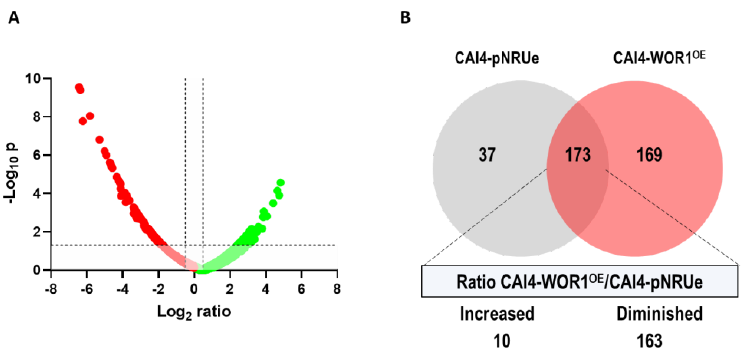
Figure 1. Proteome changes in cells overproducing Wor1. ( A ) Volcano plot of differentially abundant proteins (CAI4- WOR1 OE /CAI4-pNRUe ratio). The log 10 of the p -value is plotted against abundance (log 2 ratio) for each individual protein. Proteins that were found in lower abundance in WOR1 OE cells are shown in red whereas proteins with higher abundance are shown in green. Horizontal dotted line indicates the limit for p- values ( p = 0.05, that correspond to - log 10 p = 1.3). Vertical dotted lines indicate the log 2 ratio = ±0.5 threshold. ( B ) Venn diagram with the number of proteins identified exclusively in one strain or in both strains, based on a variability ratio <30% between replicates and a Mascot score > 13. Among those proteins less abundant in WOR1 OE , we identified cytoplasmic (74), nu- clear (32), mitochondrial (25) or ribosomal proteins (24), as well as proteins located in the mitochondrial envelope (15), plasma membrane (14), cell wall (13), cytoskeleton (7), vac- uole (3), peroxisome (2), endoplasmic reticulum (2), or Golgi (2). Among the 10 proteins